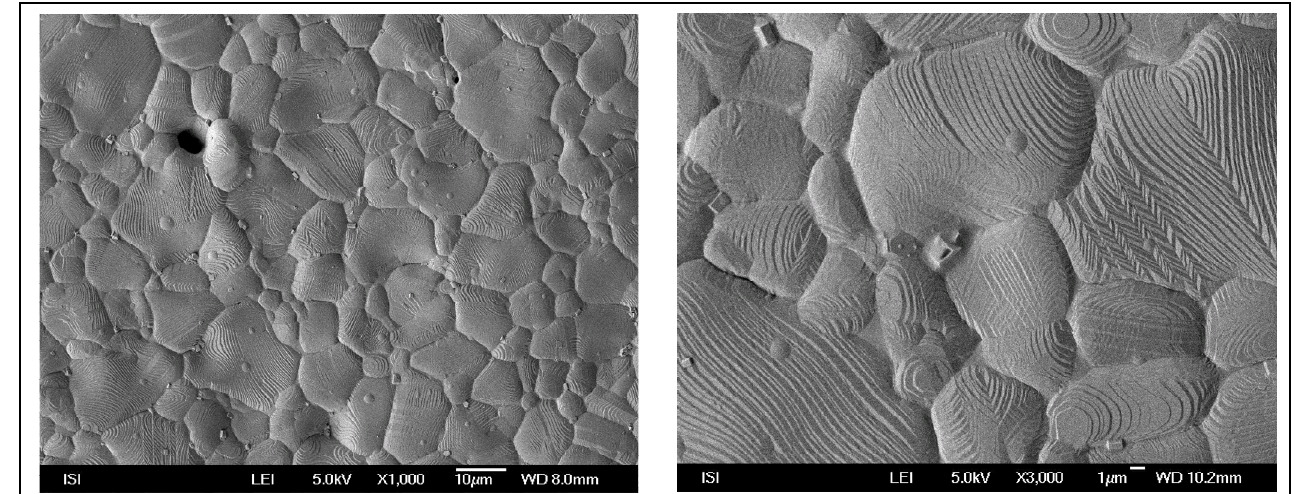
Figure 6. Surface electron microscopic microphotograph of silver working electrode surface (left), in detail